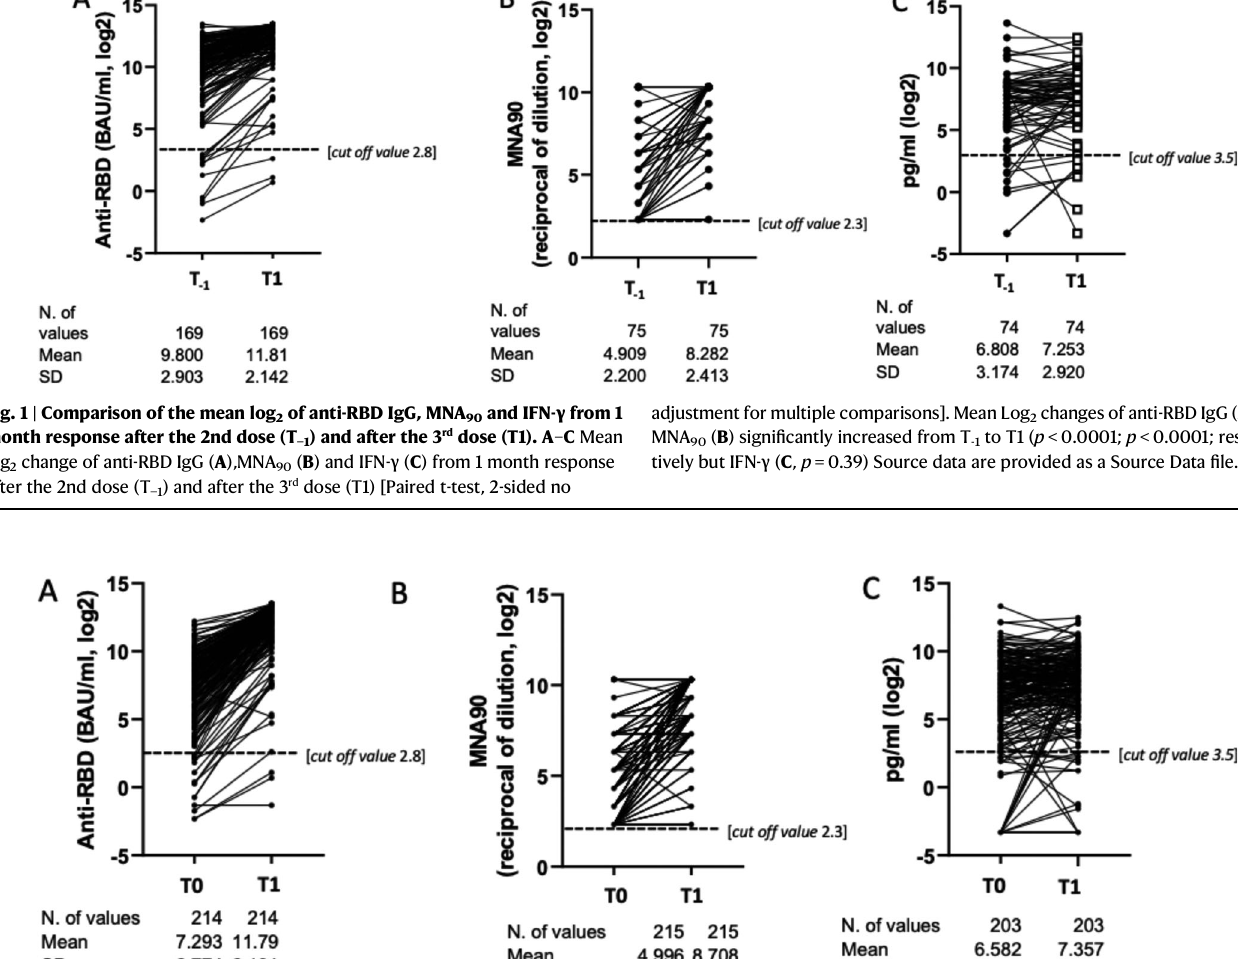
( p <0.0001, p <0.0001 and p =0.003, respectively). Source data are provided as a Source Data fi le.